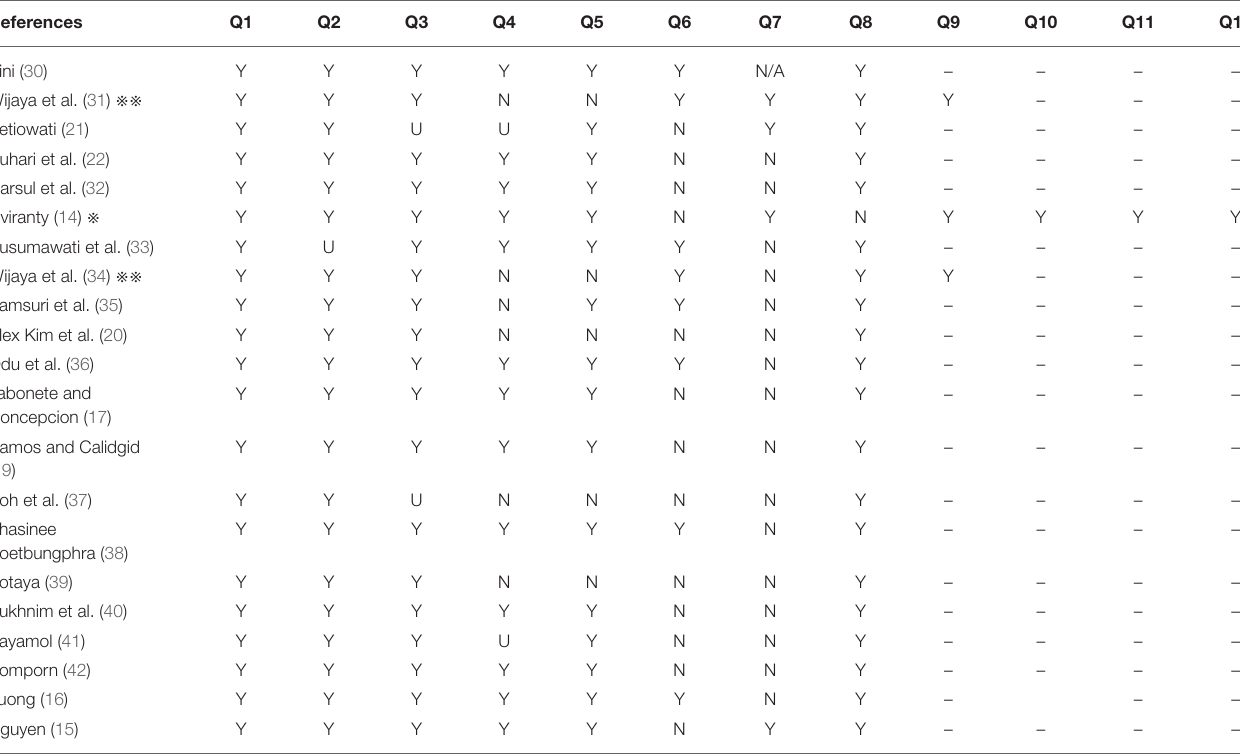
TABLE 1B | Results of the critical evaluation of each